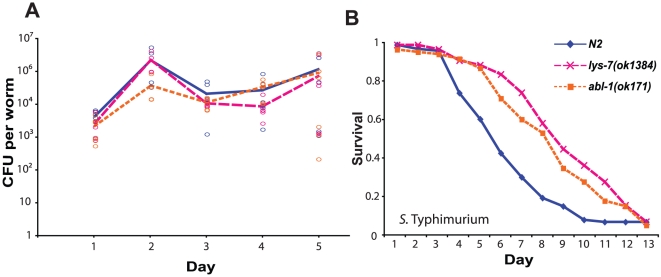

lys-7 and abl-1 mutant animals are tolerant of S. Typhimurium infection.(A) Bacterial load was assessed through viable counts. There was no difference between any of the strains, p>0.2, although there is a slight disparity between abl-1(ok171) and lys-7(ok1384) on day 4 of the infection, p<0.05, [abl-1(ok171) n = 60, lys-7(ok1384) n = 60; N2 n = 60]. (B) lys-7(ok1384) and abl-1(ok171) single mutants are tolerant to S. Typhimurium infection following a six-hour exposure, p<0.01 and p<0.0001 respectively, [lys-7(ok1384) n = 90; abl-1(ok171) n = 86; N2 n = 96].